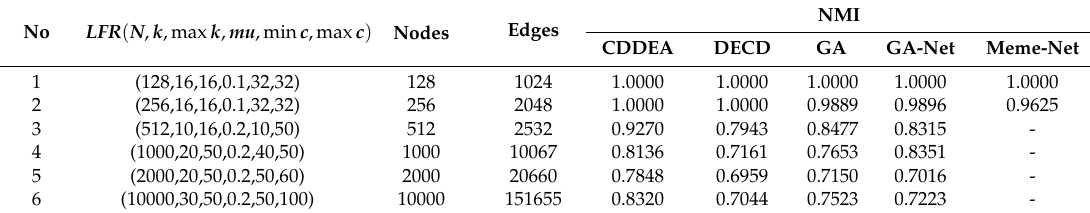
Table 8. NMI value comparison of different algorithms on LFR Networks.